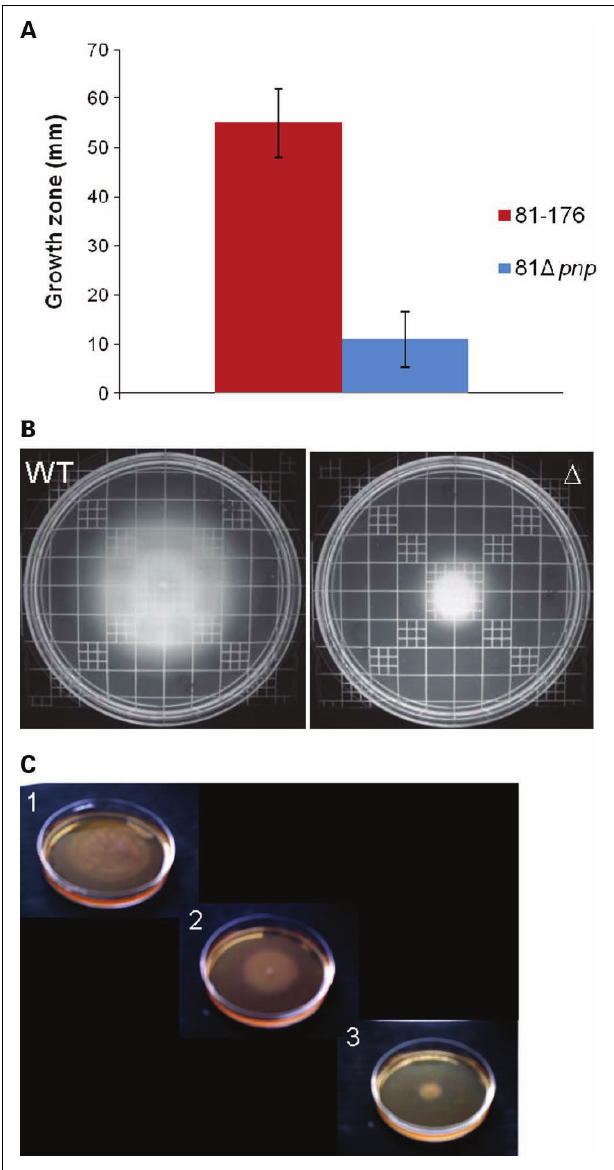
FIGURE 3 | Motility phenotypes of C. jejuni strains. Swimming ability was assessed on BHI agar containing 0.4% agar. Strains were inoculated into BHI motility agar and incubated for 48 h at 37 ◦ C under microaerobic conditions. (A) Mean diameters of four independent experiments were represented. (B) Motility agar obtained after an incubation at 37 ◦ C during 48 h. (C) Motility assay of the parental C. jejuni F38011 strain (1), the F38 (cid:2) pnp complemented strain (2), and the mutant strain F38 (cid:2) pnp (3), on BHI plates containing 0.4% agar.